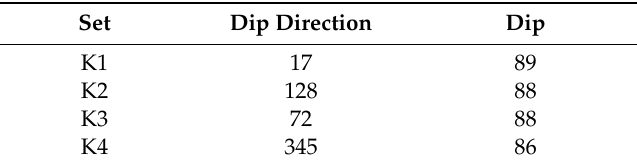
Table 2. Average attitudes of the discontinuity systems identified through geological measurements on the rock mass.